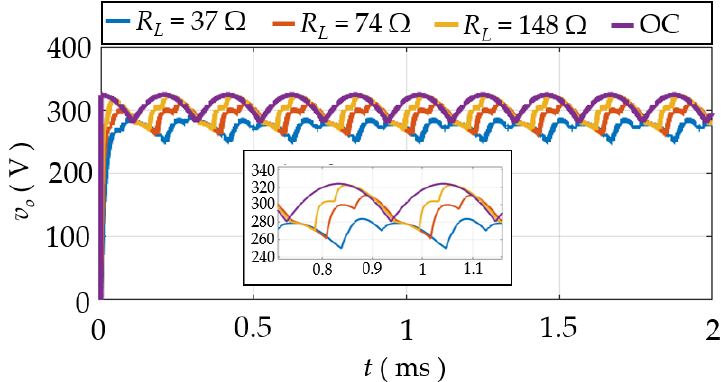
Figure 9. ATU output voltage waveforms. Table 13. ATU with input capacitor filter—simulation results.